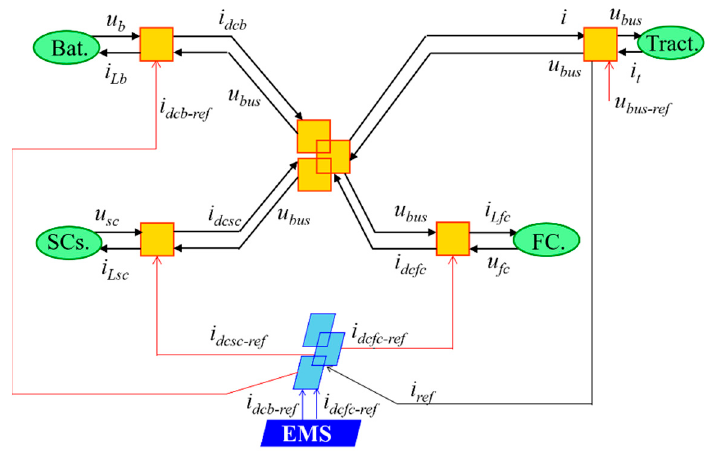
Figure 7. Energetic macroscopic representation and control scheme of the reduced model.